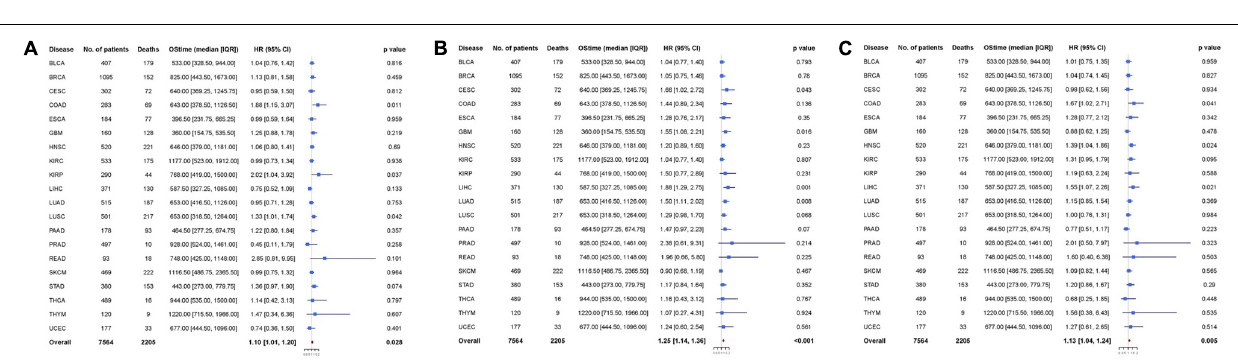
FIGURE 3 | Cox proportional hazards analyses of (A) SPARC, (B) SPP1, and (C) BGLAP across 20 cancer types. Note: age (young vs. old, the median age as the threshold), sex (male vs. female) and disease stage (stage III-IV vs. stage I-II) were included in the multivariable model for adjustment. p < 0.05 represents significant difference in survival